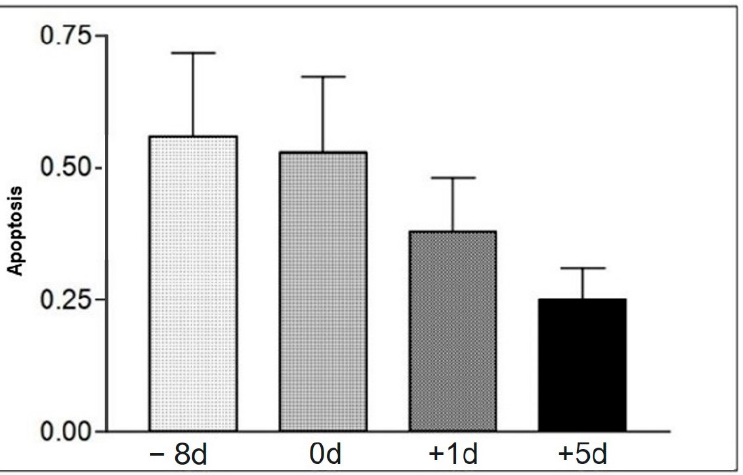
Distinct letters on the same line indicate a significant statistic difference between the results, 0 d = immediately after the race. Figure 3. Mean values of total apoptotic cells in moments − 8 d, 0 d, +1 d, and +5 d, in the samples of the animals of group II. Statistical difference according to the Tukey–Kramer test—Beltsville, 2003.